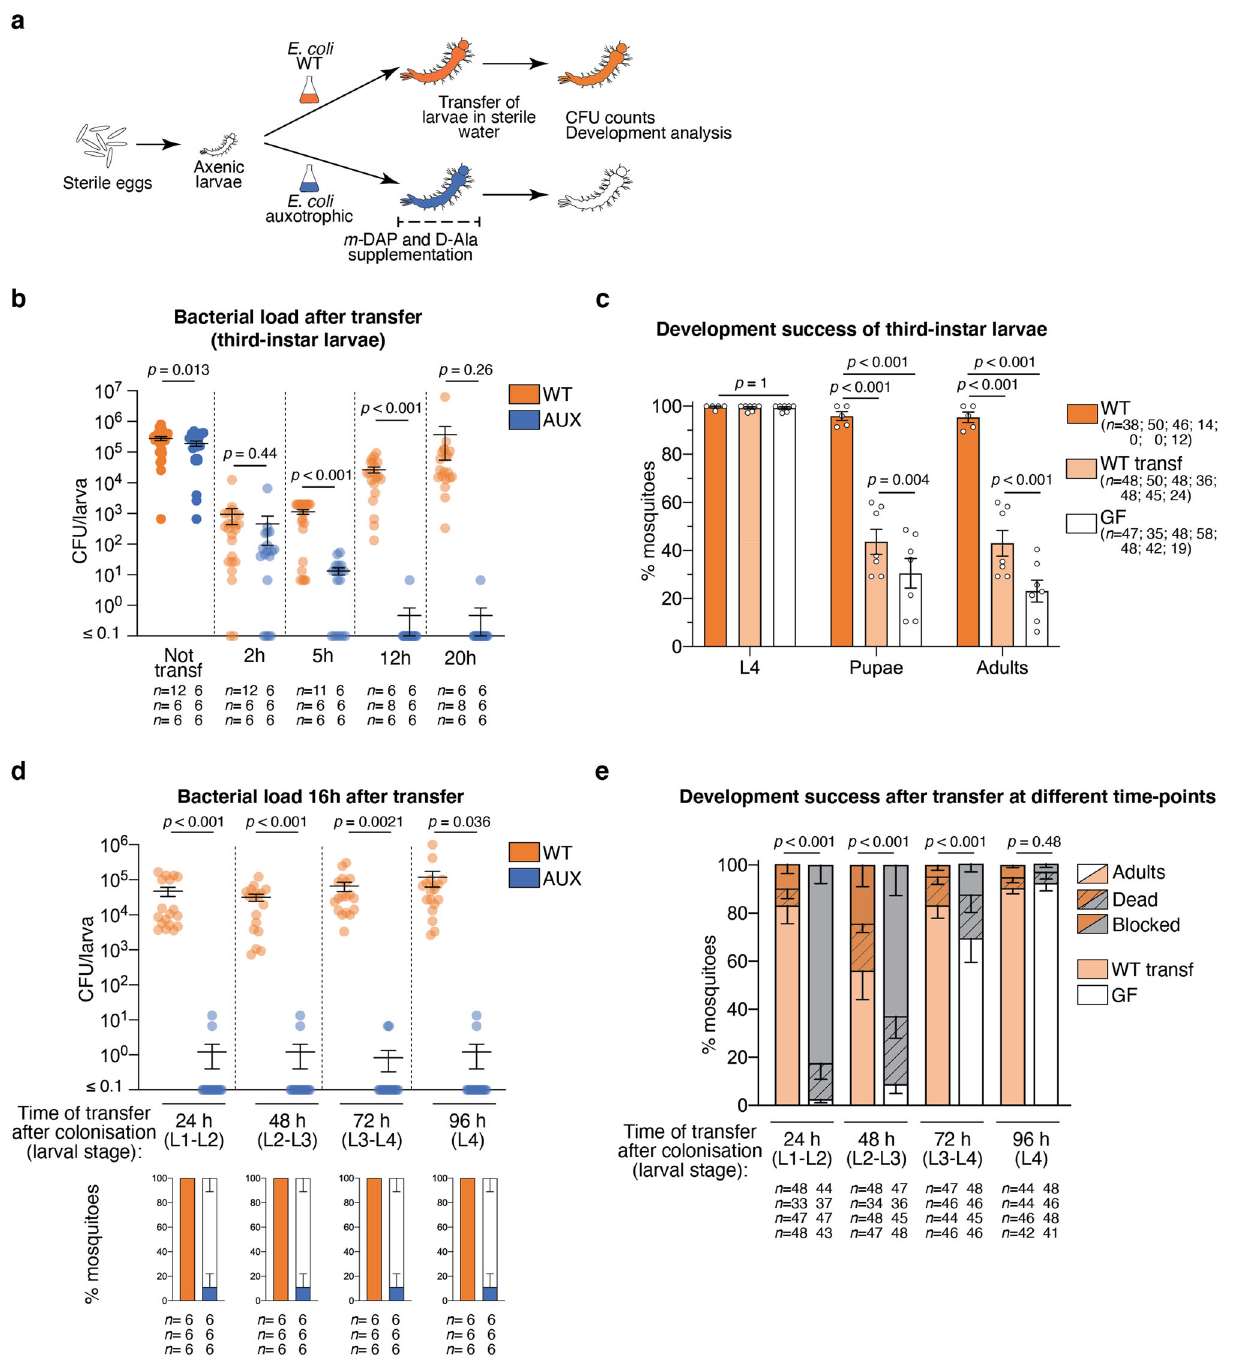
Fig. 3 Decolonisation dynamics and developmental analysis of germ-free larvae obtained via reversible colonisation. a Schematic representation of the experimental setup. To stop bacterial colonisation, larvae are transferred to a sterile rearing water lacking meso -diaminopimelic acid ( m -DAP) and D- alanine (D-Ala). Bacterial loads are measured via colony forming units (CFU) count at different time-points and the development success of transferred larvae is assessed. b Bacterial loads of third-instar larvae gnotobiotic for wild-type (WT, orange) or auxotrophic (AUX, blue) E. coli after 2, 5, 12 and 20 h from transferring into sterile rearing water. c Development success of larvae continuously colonised (WT, orange), reared on wild-type (WT transf, light orange) or auxotrophic (GF, white) E. coli until the third instar and transferred into sterile rearing water. The proportion of individuals reaching the fourth instar (L4), the pupal stage and adulthood is shown. d Bacterial loads of larvae gnotobiotic for wild-type (WT, orange) or auxotrophic (AUX, blue) E. coli transferred into sterile rearing water at different developmental stages (L1: fi rst instar, L2: second instar, L3: third instar, L4: fourth instar). CFU counts were measured 16 h after transfer. e Proportion of individuals reaching adulthood (full bar), dying (striped dark bars) and with stalled development (dark bars) after being reared with wild-type (WT transf, light orange) or auxotrophic (GF, white) E. coli and being transferred into sterile rearing water after 24, 48, 72 or 96 h since colonisation. In ( b – e ), data show mean ± SEM of three ( b , d ), fi ve ( c , WT), seven ( c , WT transferred and GF) or four ( e ) independent replicates. The exact number of individuals analysed per condition and replicate is indicated in each panel. Statistical signi fi cance was determined with generalised linear mixed models and least square means with Bonferroni correction. Exact p values are indicated in the fi gure. See Table S1 for detailed statistical information. Source Data are provided as a Source Data fi